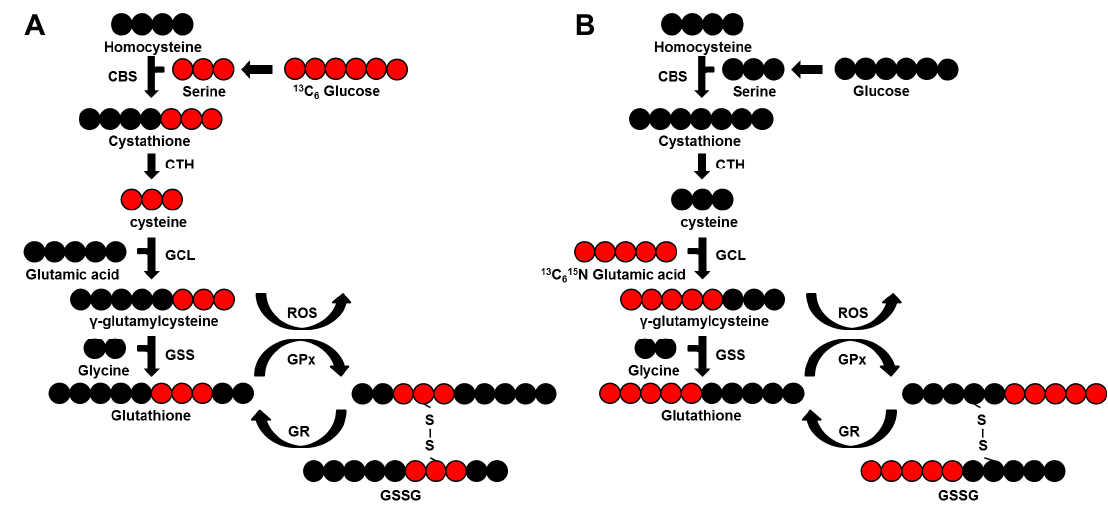
Figure 7. Scheme of the de novo synthesis pathway of glutathione. ( A ) based on 13 C 6 glucose and ( B ) on 13 C 515 N glutamic acid as tracers. Red circles, 13 C 6 ; black circles, 12 C 6 . CBS, cystathionine b-synthetase; CTH, cystathionase; GCL, glutamate-cysteine ligase; GSS, glutathione synthetase; GPx, glutathione peroxidase; GR, glutathione reductase; GSSG, oxidized GSH. Of note, GSSG can exist in three versions in parallel, as it is made of two GSH molecules: 13 C 6 , 13 C 3 , and 12 C when 13 C 6